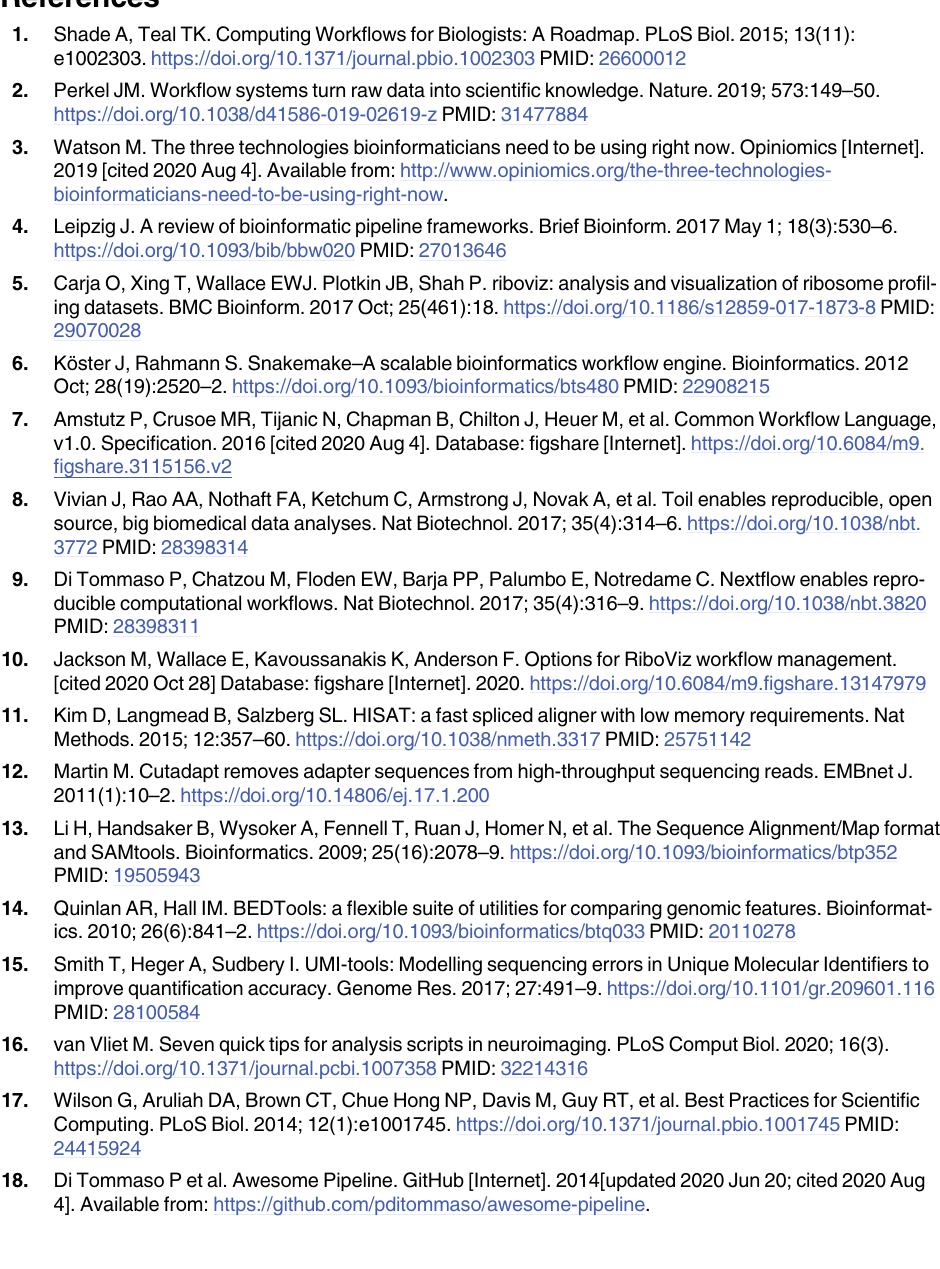
S2 Fig. RiboViz workflow steps invoked when processing multiplexed sample